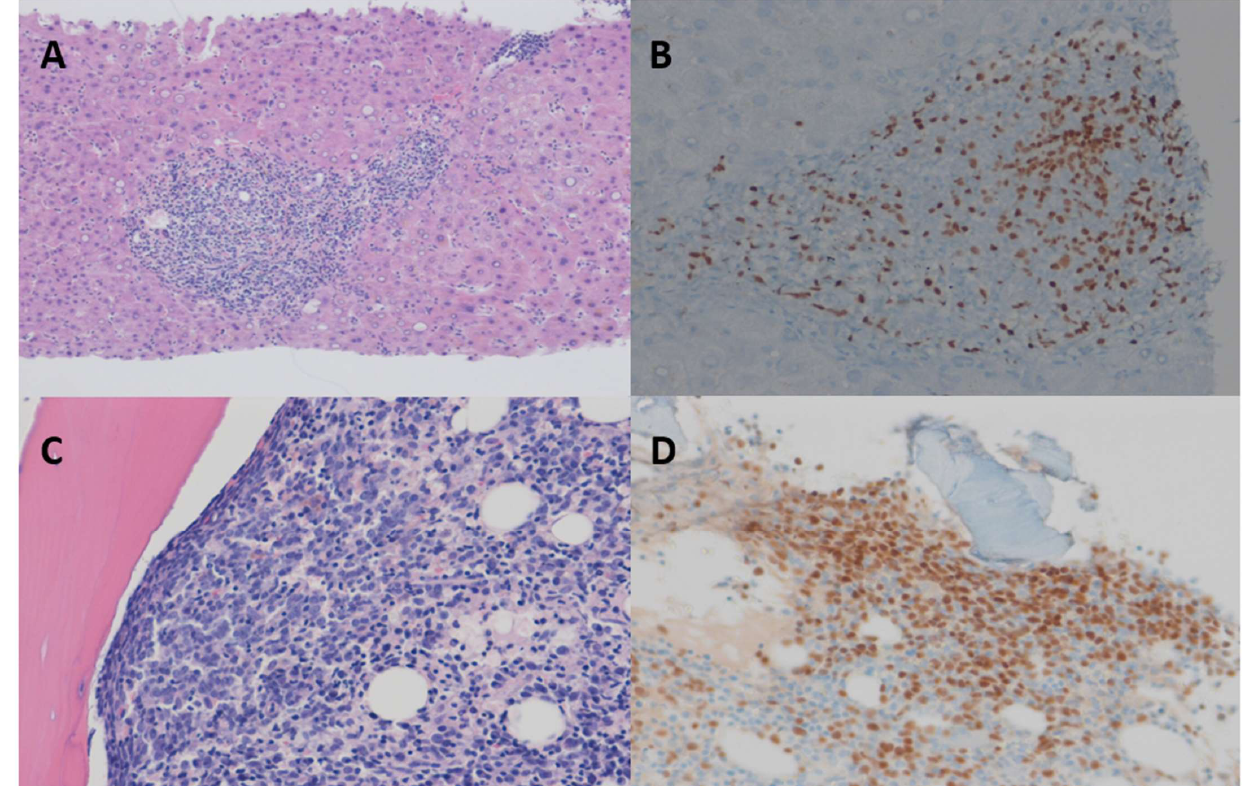
Figure 2. Histologic findings of the liver. ( A ) Liver biopsy revealed atypical lymphocyte infiltration in the portal tract (hematoxylin–eosin [HE] staining, ×10, respectively). ( B ) Medium-sized atypical lymphocyte infiltration with positive periodic acid–Schiff (PAS) 5 (×100). ( C ) Bone-marrow biopsy revealed large atypical lymphoid infiltrating bone-marrow (HE staining, ×200, respectively). ( D ) Medium-sized atypical lymphocyte infiltration with positive PAS 5 (×200). To evaluate the possible involvement of other organs in lymphoma, positron emission tomography-CT (PET-CT) was performed with a bone-marrow biopsy and the result showed lymphoma involvement of bone-marrow with Bcl-2(+), Ki67( − ), MYC( − ). The PET-CT revealed F-18 fluorodeoxyglucose uptake in the whole bone-marrow and spleen, and mild uptake in the liver (Figure 3). The final diagnosis was Ann Arbor stage IV diffuse large B-cell lymphoma (DLBCL), with liver, spleen, and bone-marrow involvement (Figure 2C,D). doxorubicin, vincristine, and prednisone chemotherapy (mini R-CHOP), taking into con- sideration his age. Chemotherapy was considered markedly effective, as his laboratory test-results were as follows: white-blood-cell count, 5360/ µ L (absolute nuclear count: 4464); hemoglobin level, 9.8 g/dL; platelet count, 72,000/ µ L; C-reactive protein level, 0.6 mg/dL; serum AST level, 15 IU/L; ALT level, 17 IU/L; and LDH level 338 IU/L (Figure 4). After chemotherapy, he underwent a sufficient recovery period, was in better condition, and underwent regular